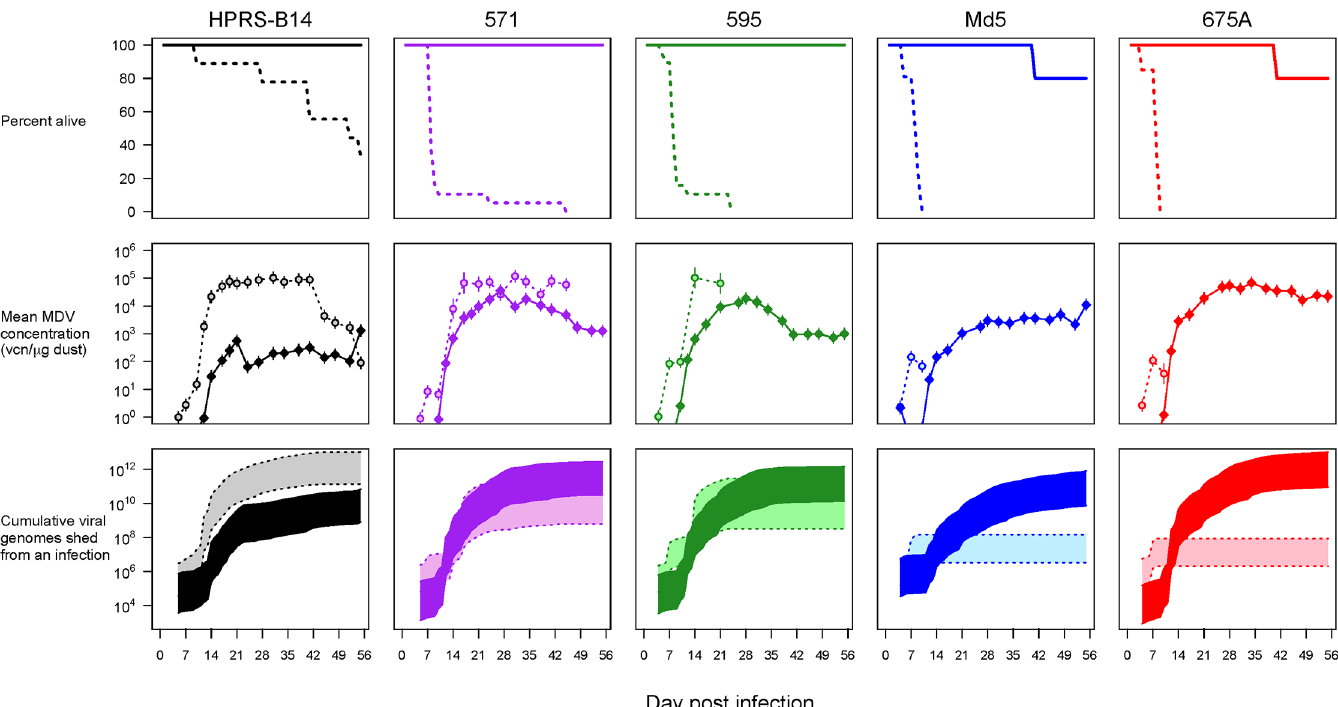
Fig 1. Impact of vaccination on mortality and viral shedding of five strains of MDV. Experiment 1. Groups of 20 Rhode Island Red chickens were unvaccinated (dotted lines, light shading) or HVT-vaccinated (solid lines, dark shading) at 1 d of age and challenged with viral strains HPRS-B14 (black), 571 (purple), 595 (green), Md5 (blue), or 675A (red) 8 d later. Viral strains vary in virulence in unvaccinated hosts, and vaccination protects against death ( top panels , with strains arranged in order of increasing virulence from left to right.). Vaccination suppresses the concentration of virus in dust, but by keeping hosts alive, prolongs the infectious periods of hyperpathogenic MDV ( middle panels ). This means that cumulative number of virus genome copies (VCN) shed per bird is suppressed by vaccination for the least virulent strain and enhanced by several orders of magnitude for the most virulent ( bottom panels ). Error bars and shaded regions indicate 95% confidence interval (c.i.) Raw data can be found at http://dx.doi.org/10.5061/dryad.4tn48.